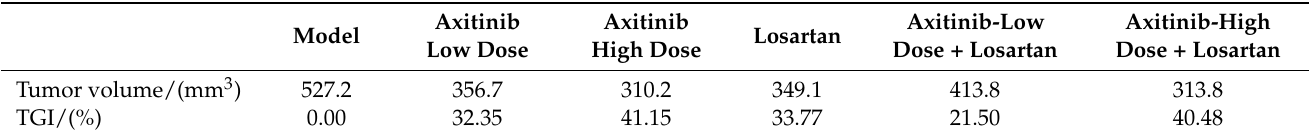
Figure 4. Effects of axitinib combined with losartan on skin vascular permeability in mice. ( A ) Ex- perimental diagram. ( B ) Effect of different groups on skin vascular permeability. ### p < 0.001 vs. VEGF-A group, *** p < 0.001 vs. control PBS group. Table 1. Effects of axitinib combined with losartan on the growth of xenograft